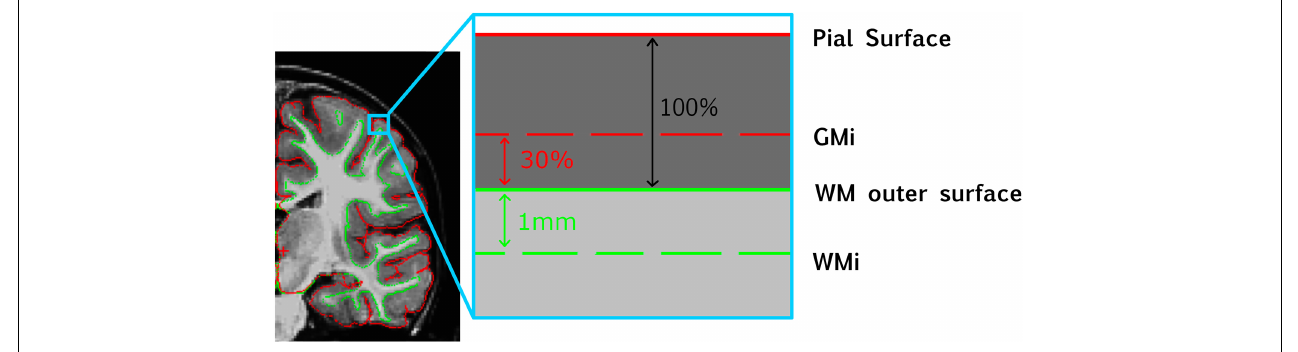
FIGURE 1 | Schematic representation of how GWC is computed at each vertex. GMi, gray matter intensity; WM, white matter; WMi, WM